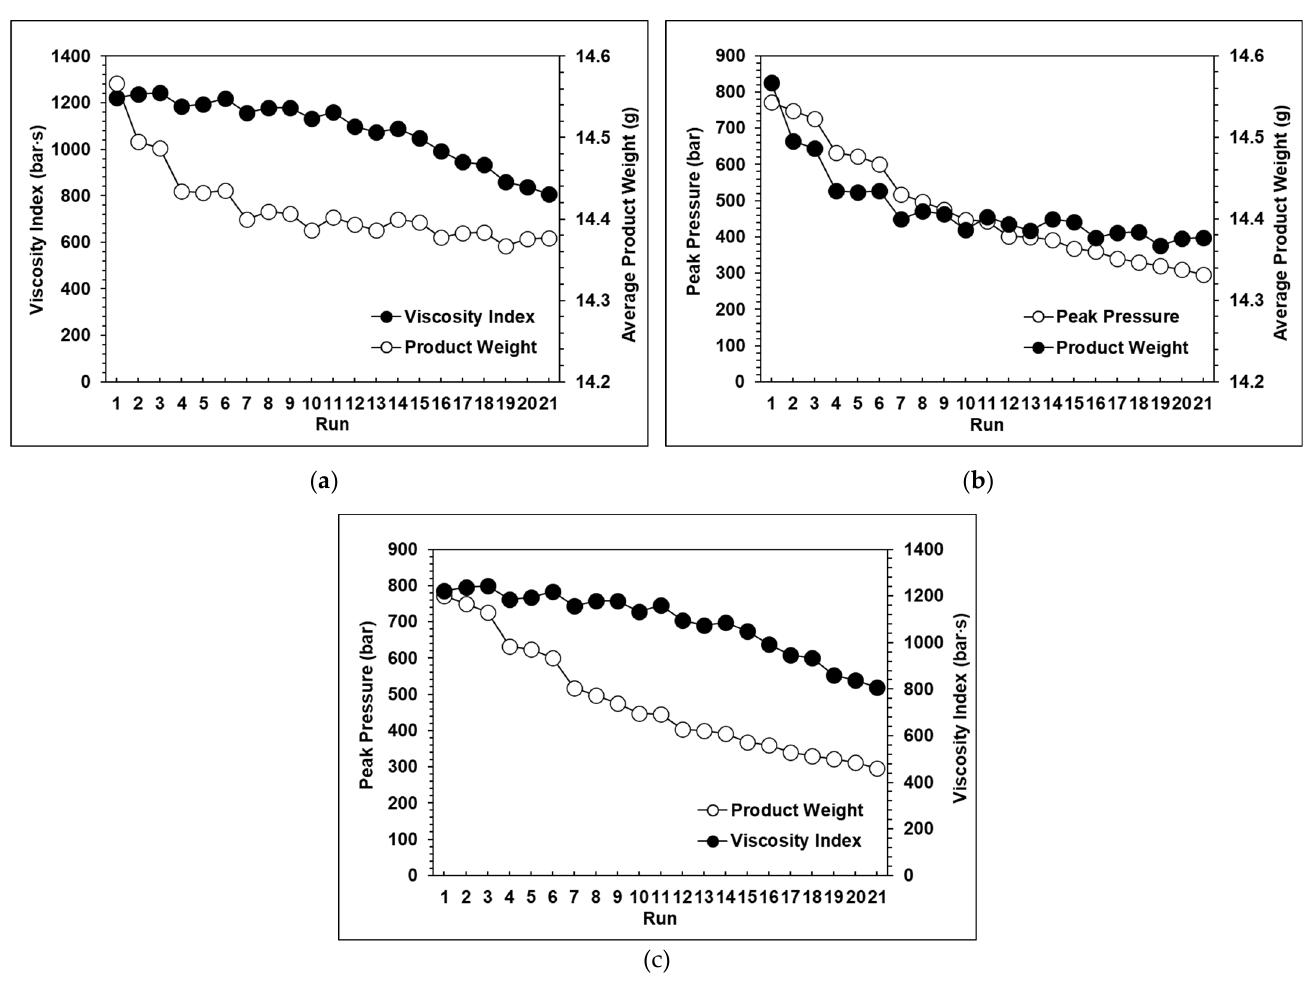
Figure 14. ( a ) Relationship between the product weight and peak pressure after three seconds of packing time; ( b ) Relationship between the product weight and the viscosity index after three seconds of packing time; ( c ) Relationship between the viscosity index and the peak pressure after three seconds of packing time.